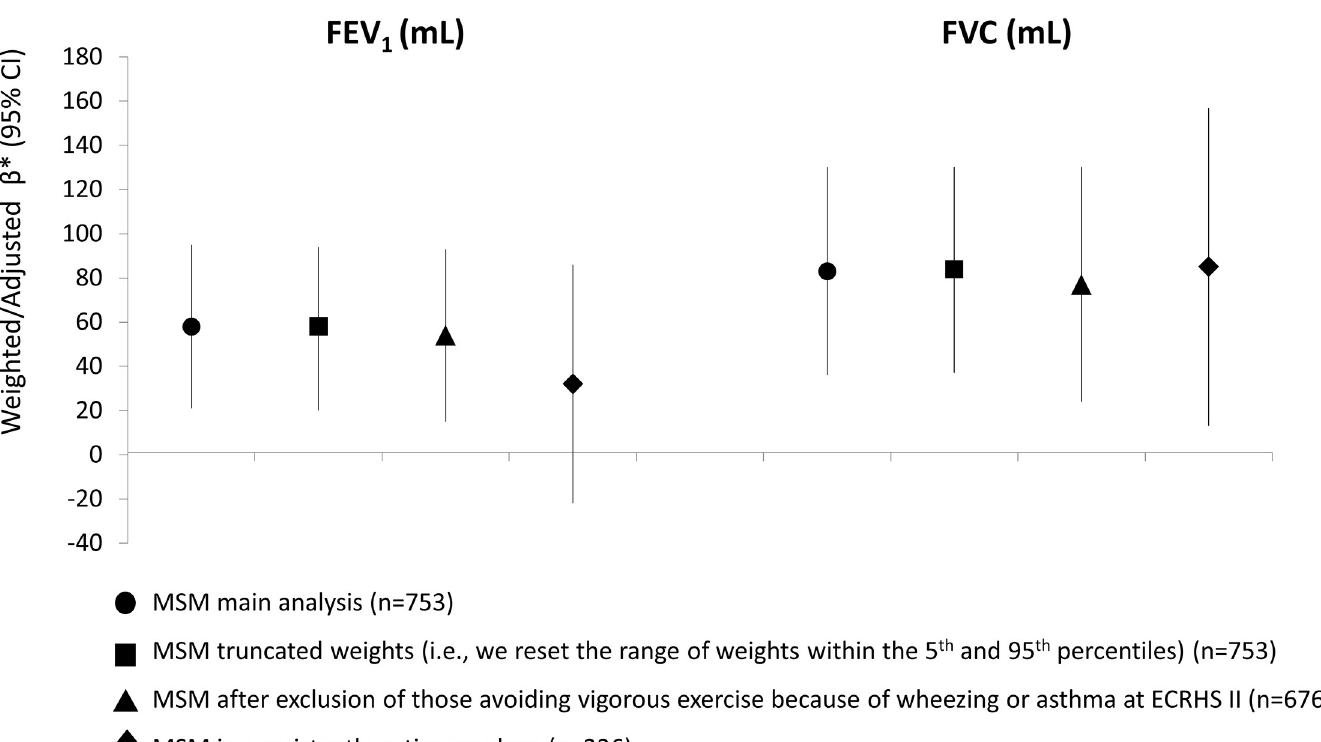
Fig 3. Effects of physical activity on lung function estimated using MSMs (main and sensitivity analysis) in the ECRHS cohort. β : difference in the expected lung function measure comparing active versus non-active individuals. � Models included. number of pack-years smoked, passive smoking exposure, weight, sex, education, age, age-squared, height, occupation, AHEI-2010 score, respiratory infection in childhood), and centre.